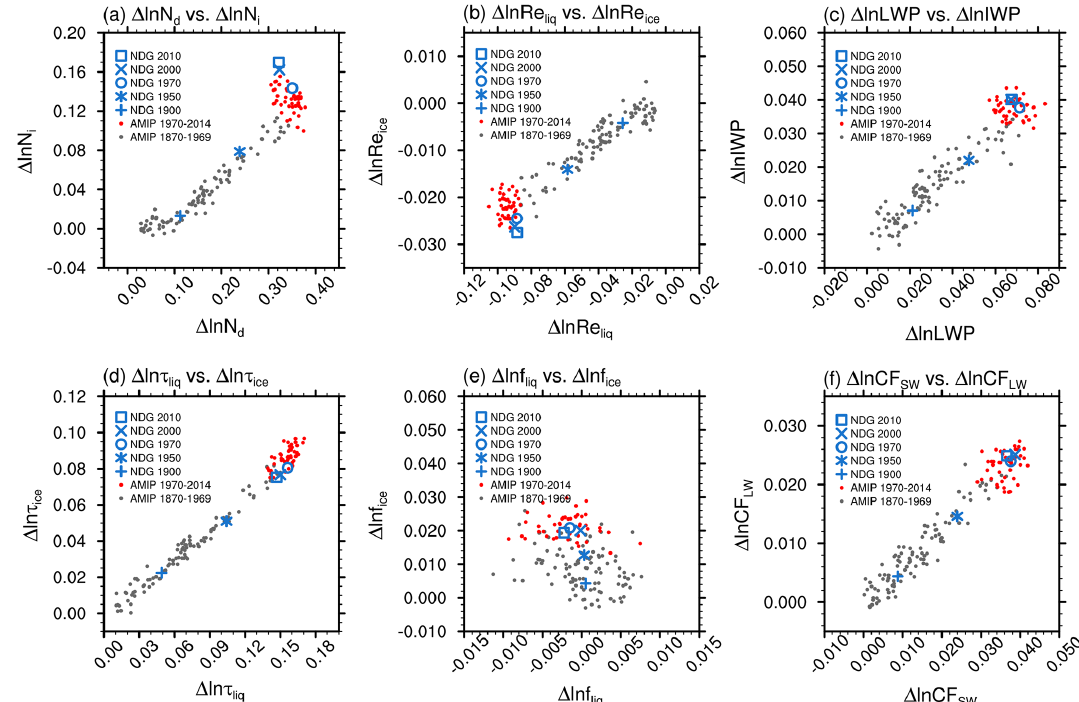
Figure 11. As Fig. 7, but for relationships between changes in liquid and ice cloud properties as well as in SW and LW cloud radiative forcing. (cid:49) ln Re ice , (cid:49) lnIWP ice , (cid:49) ln τ ice , (cid:49) ln f ice , and (cid:49) lnCF LW are the relative changes in the effective radius of cloud ice at the cloud top, ice water path in stratiform clouds, ice cloud optical depth, ice cloud fraction, and longwave cloud radiative forcing, respectively. (cid:49) ln X = (cid:49)X/X PD . Dark grey dots indicate estimated values from AMIP PD/PI simulations for the years 1870–1969, while red dots are the estimated values for the years 1970–2014. Each dot represents the ensemble-averaged global annual mean field for a certain year. Blue markers show the estimates based on nudged simulations. See Sect. 4.4 for